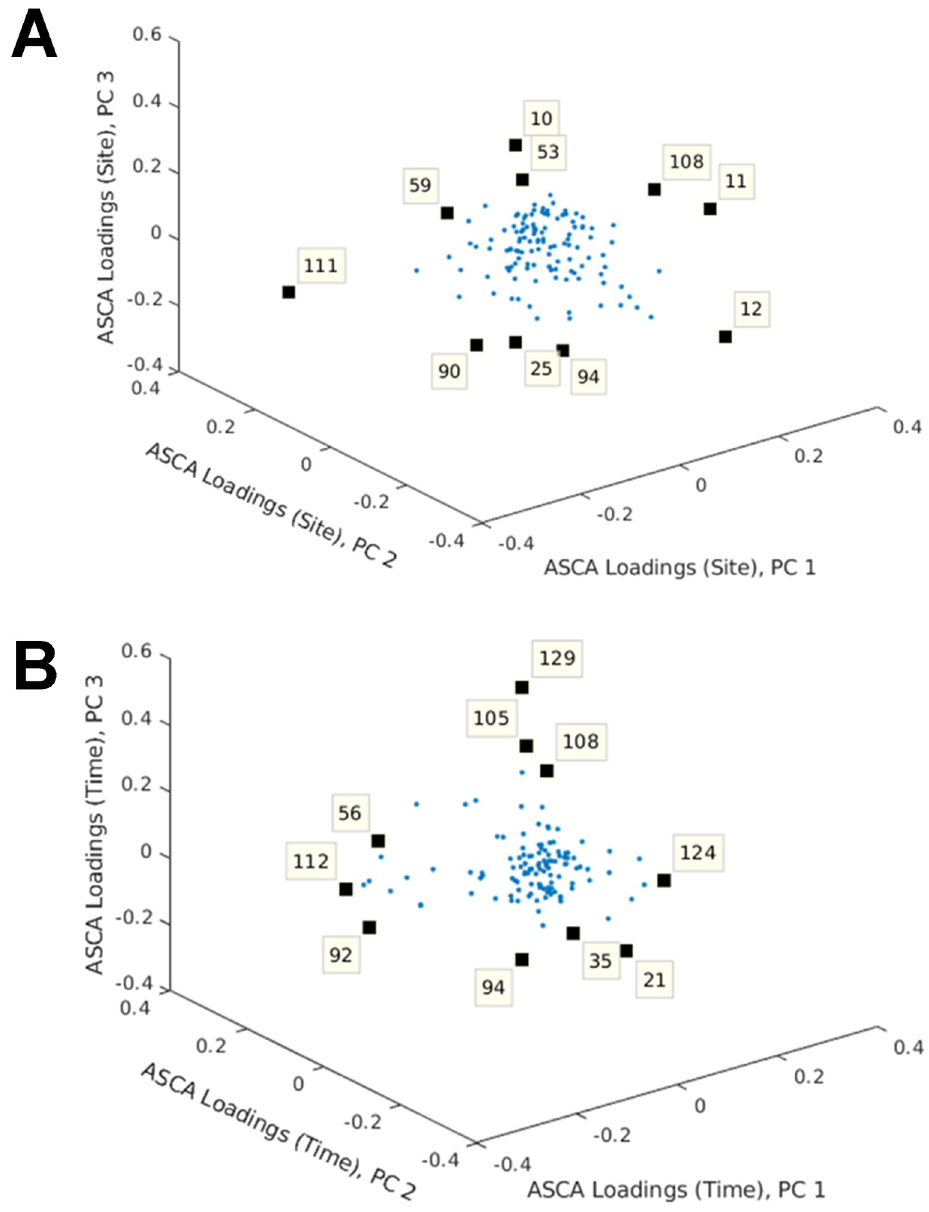
Fig 4. Analysis of variance–simultaneous component analysis (ASCA) loadings plot for wound headspace metabolome. (A) ASCA loadings plot for site: 10, 11, 12, 25, 53, 59, 90, 94, 108 –unknown; 111–1,3-bis (1,1-dimethylethyl)benzene. (B) ASCA loadings plot for time: 21, 35, 56, 92, 94—unknown; 105–1,5-dimethyl- 2-oxabicyclo[3.2.1] nonan-7-one; 108—unknown; 112–1,3-bis(1,1-dimethylethyl) benzene; 124 –unknown; 129— isobutyl-2,2,4-trimethyl-3-hydroxypentanoate.